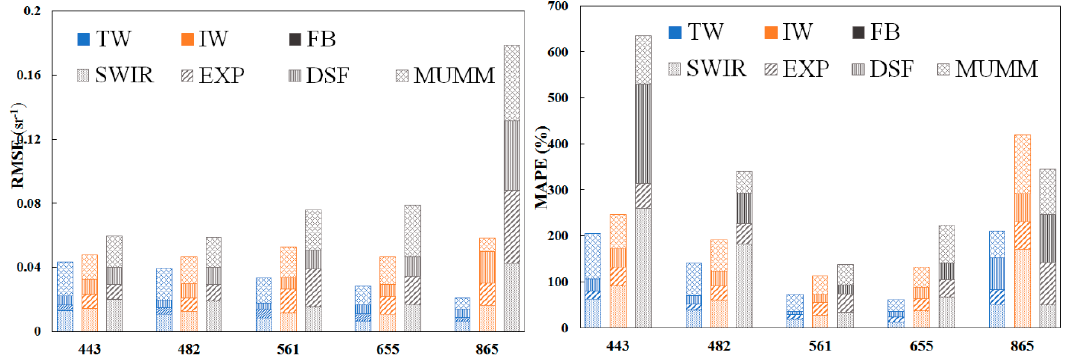
Figure 10. Distribution of RMSE ( right ) and MAPE ( left ) of bands on different water types. Blue is TW (turbid water), orange is IW (in-water algae) and black is FB (floating bloom). The different patterns of column represent different water-AC algorithms.